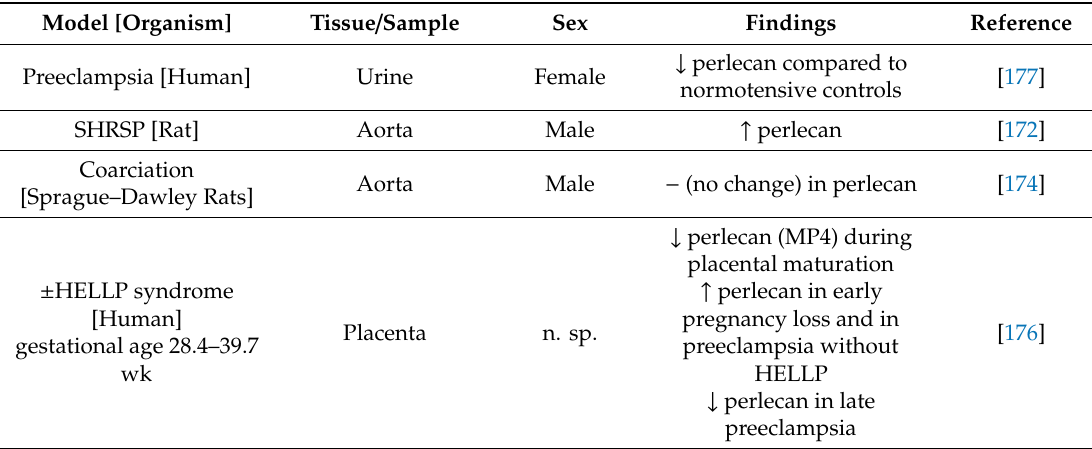
Table 4. Hypertension and